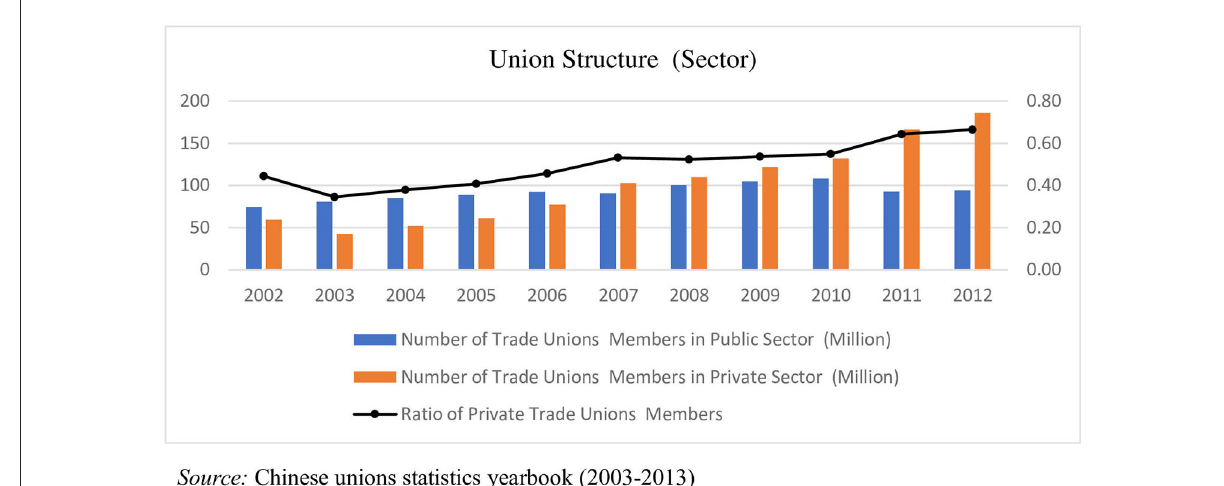
FIGURE2 Union members structure by sector.